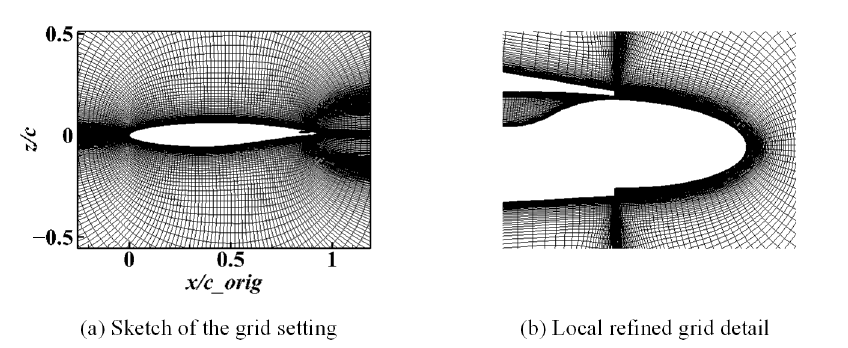
Figure 9. Medium mesh around the trailing edge for RAE2822 with Coanda surface ( Ma = 0.3 at α = 3 ◦ ).